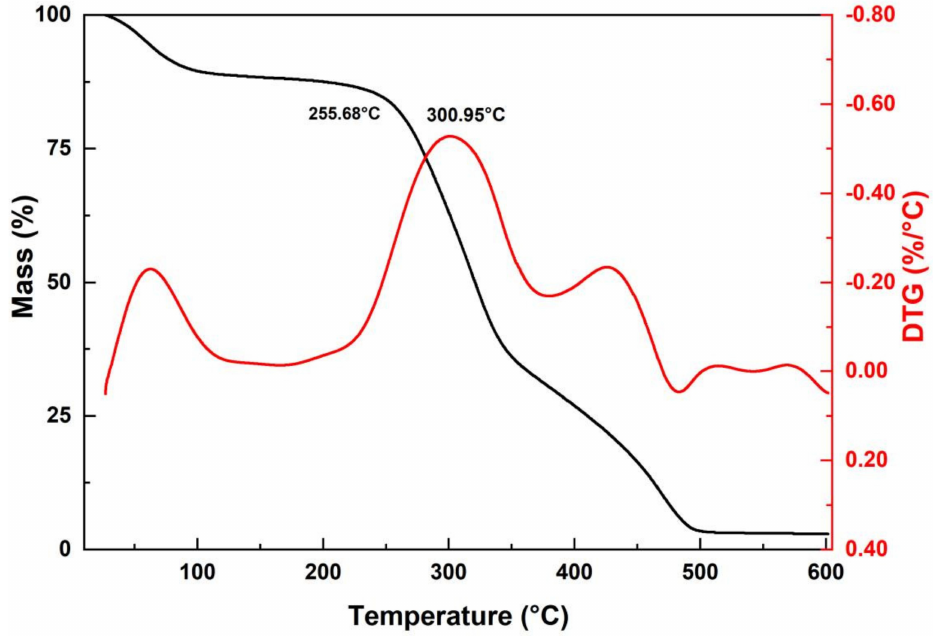
Figure 5. TGA/DTG curve of the sedge